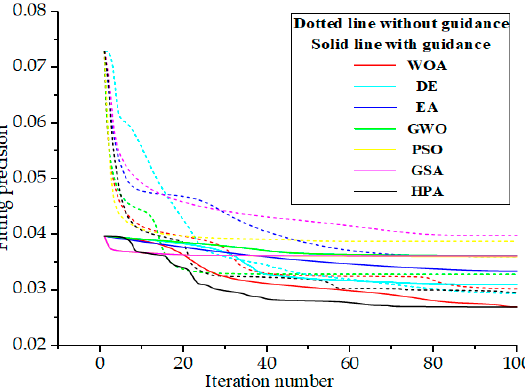
Figure 13. Comparison of the effect of various optimization algorithms on face contour fitting.